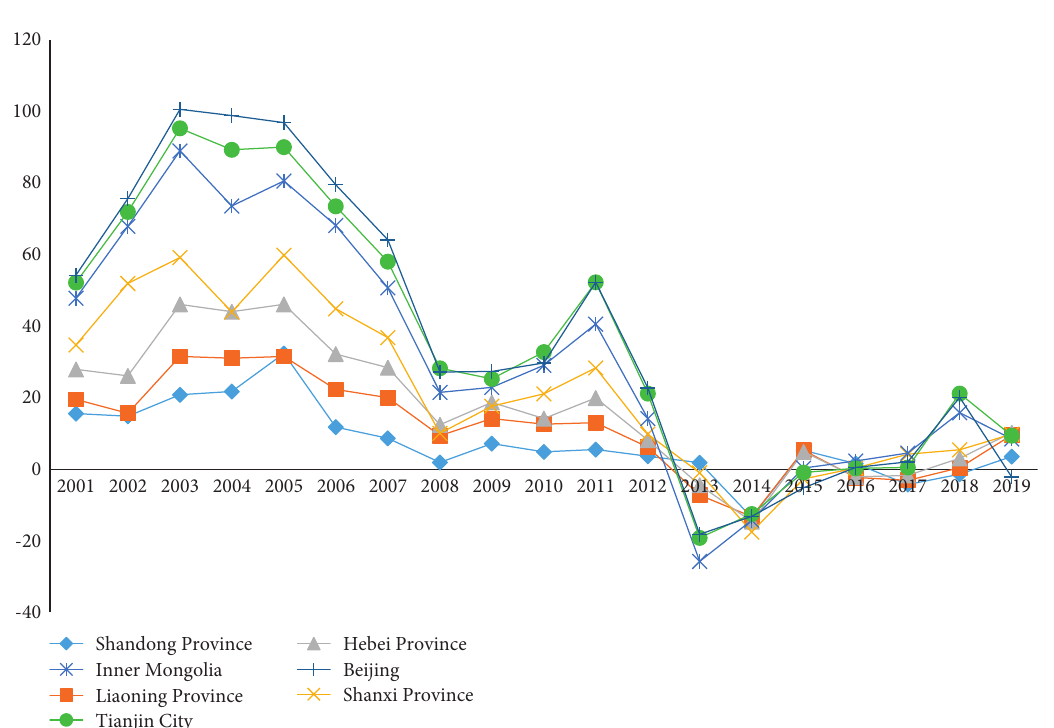
Figure 1: Total carbon emissions of provinces in the Bohai Rim region (unit: 10,000